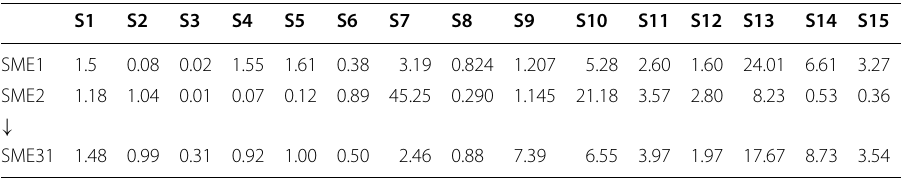
Table 7 Financial data of the selected SMEs for sub-criteria